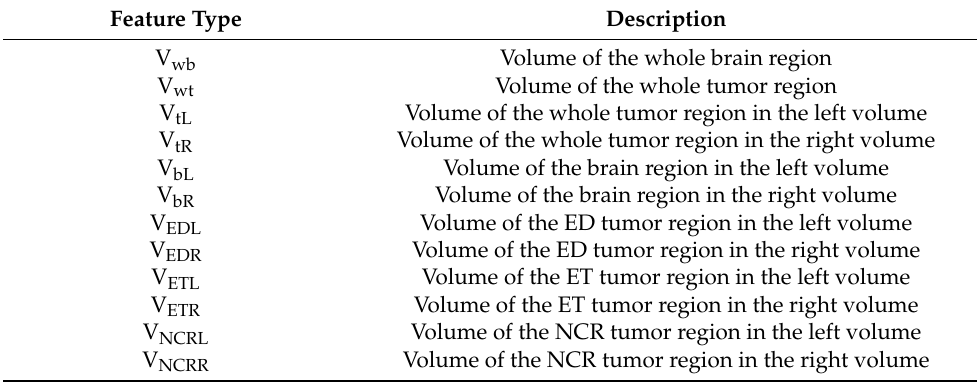
Table A1. Volumetric features extracted from mid-sagittal plane approach.